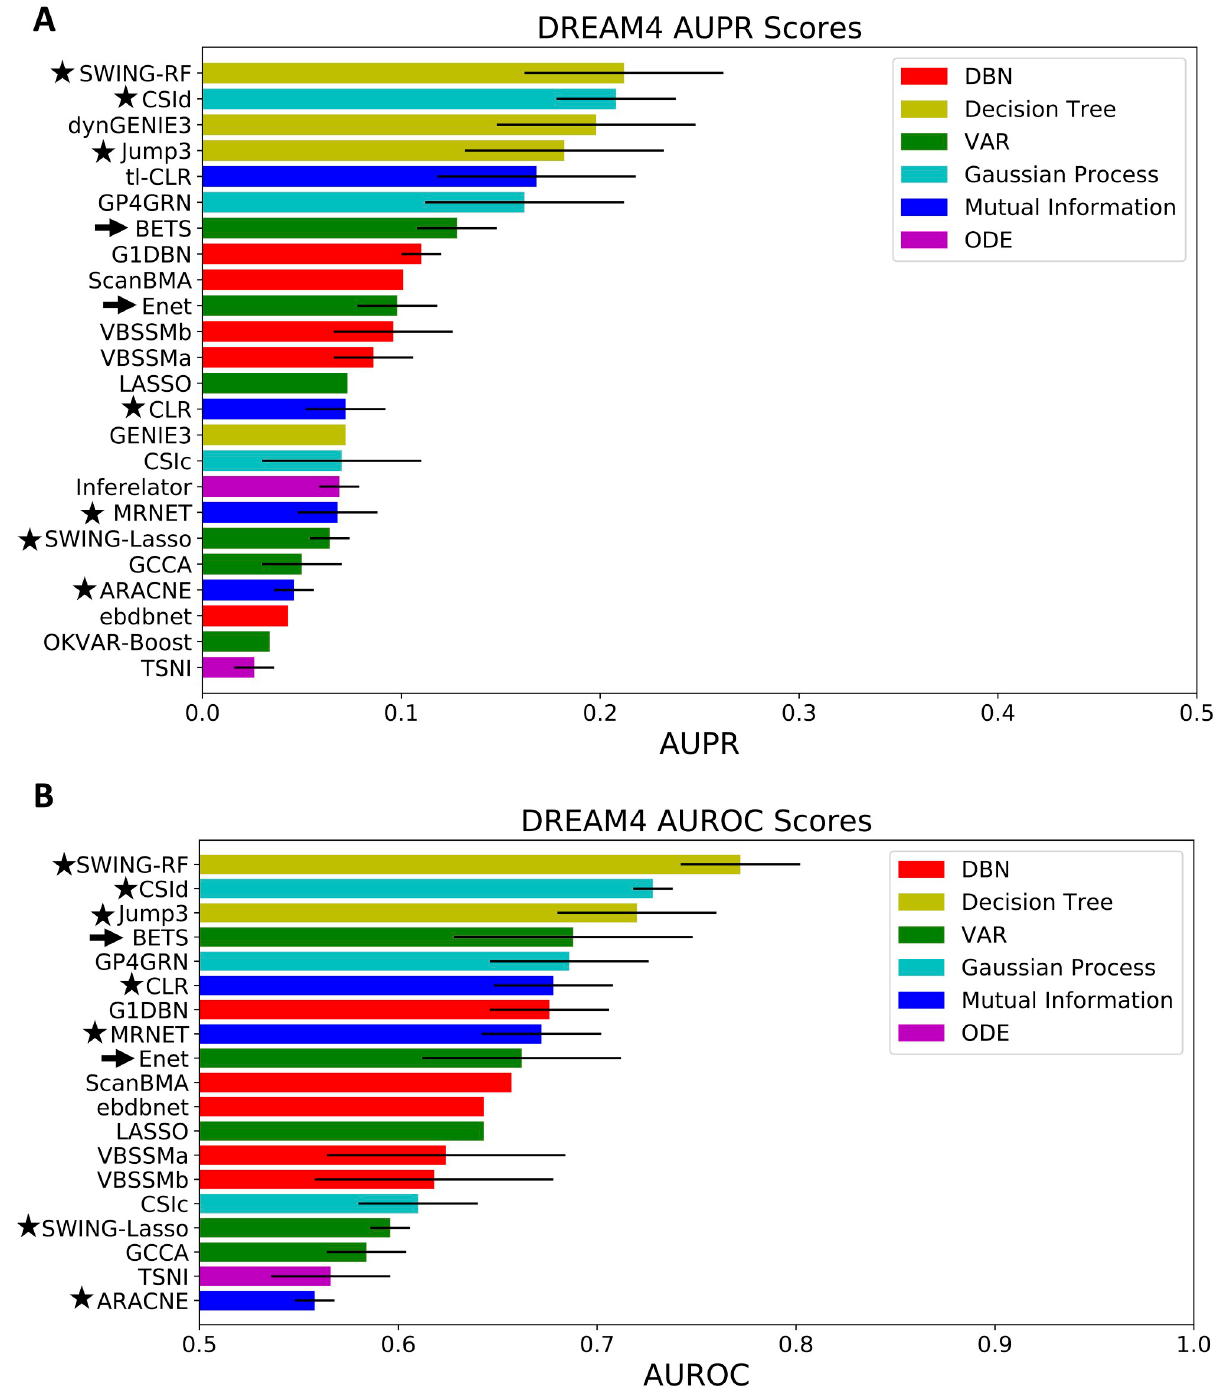
Fig 2. Algorithm performance on the DREAM community benchmark. A) AUPR scores from 24 methods , averaged across the five DREAM networks. B) AUROC scores from 19 methods , averaged across the five DREAM networks. Arrows indicate our methods. Stars indicate methods that we ran in-house; results were consistent with reported results. The bars reach one standard deviation from the average as calculated across the five DREAM networks; no bar indicates the standard deviation was not reported. See also S1–S5 Tables.